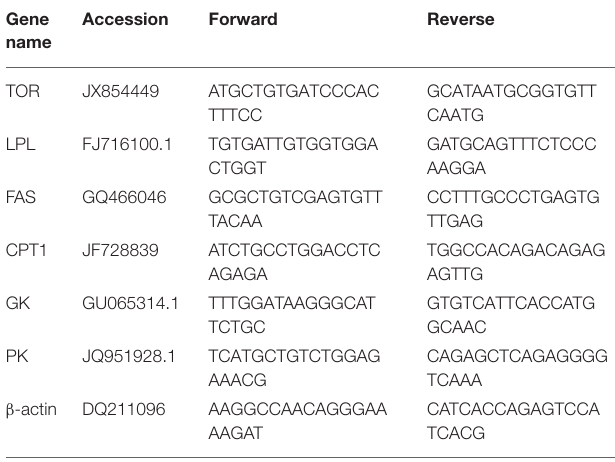
TABLE 2 | The primers for